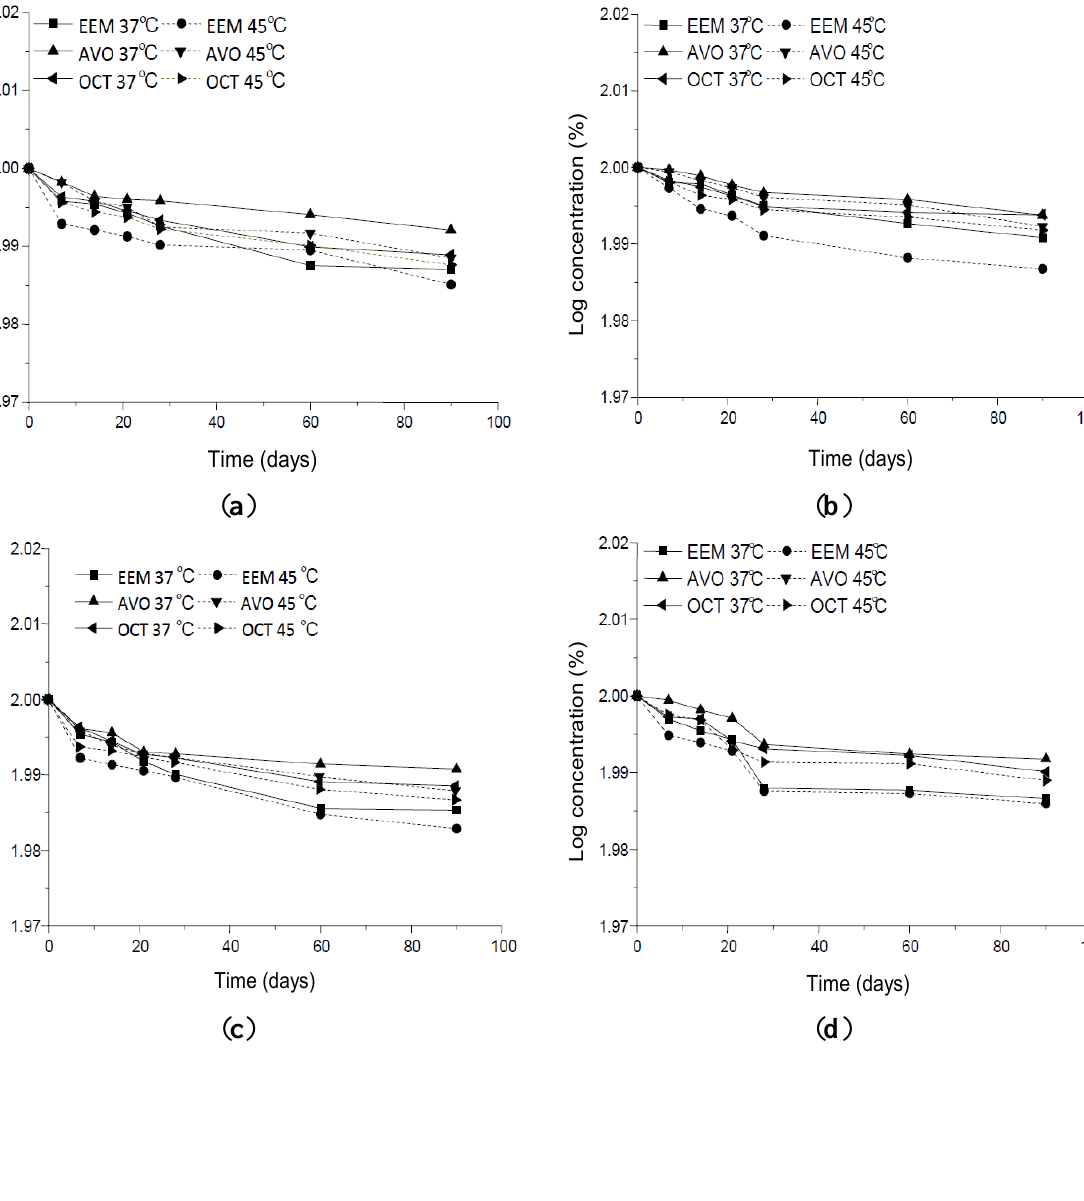
inorganic UV filters ( b ) CePO